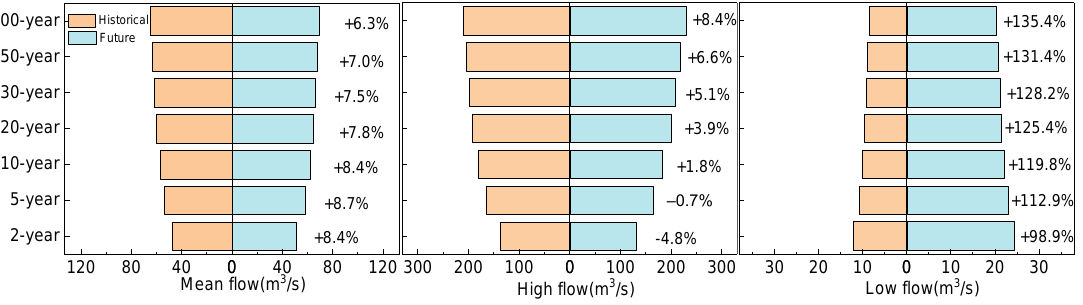
Figure 13. The projected mean flows, high flows, and low flows for different return periods.